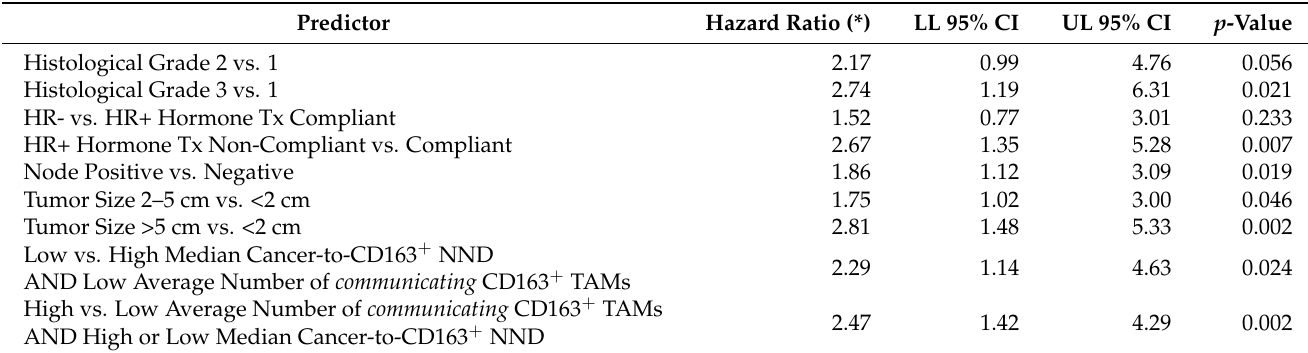
Table 4. Bias-adjusted results from the parsimonious Cox models with combined CD163 + TAM marker.